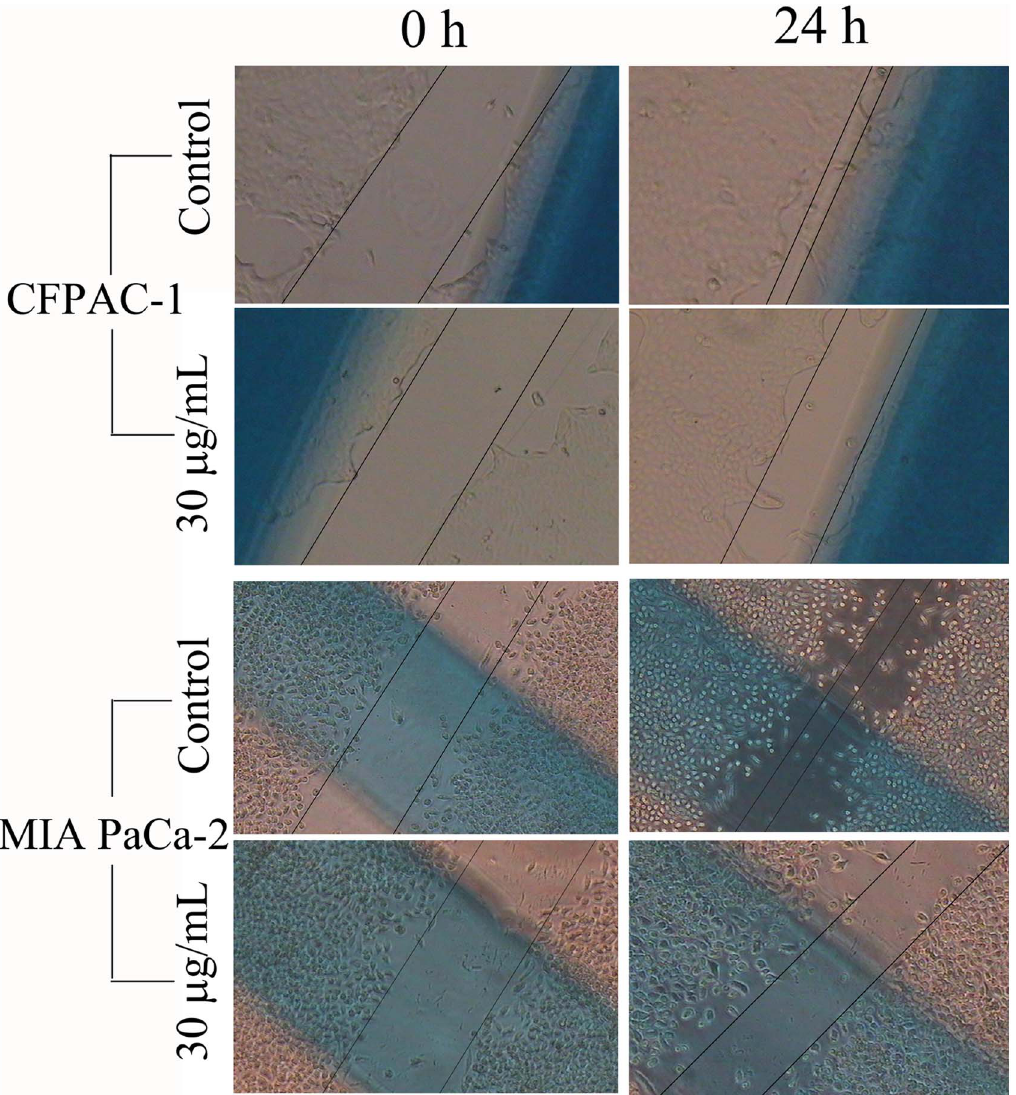
Figure 6. Spiclomazine suppressed cell migration determined by wound healing assay. The images of cell monolayer with scored wound at 0 h and 24 h after being incubated with 0.1%DMSO (final concentration) and 30.0 m g/mL spiclomazine were photographed by an inverted phase microscope. At t =24 h, visualization of the distance of wound closure (compared with control at t =0) was observed in three-independent wound sites per group.